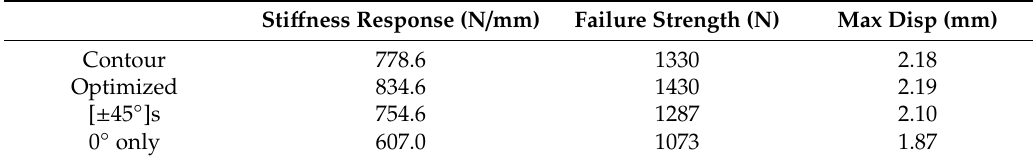
Figure 30. Load vs. displacement curves of CFRP spur printed by various tool-path. Table 4. Test results of sti ff ness response of CFRP-Nylon.